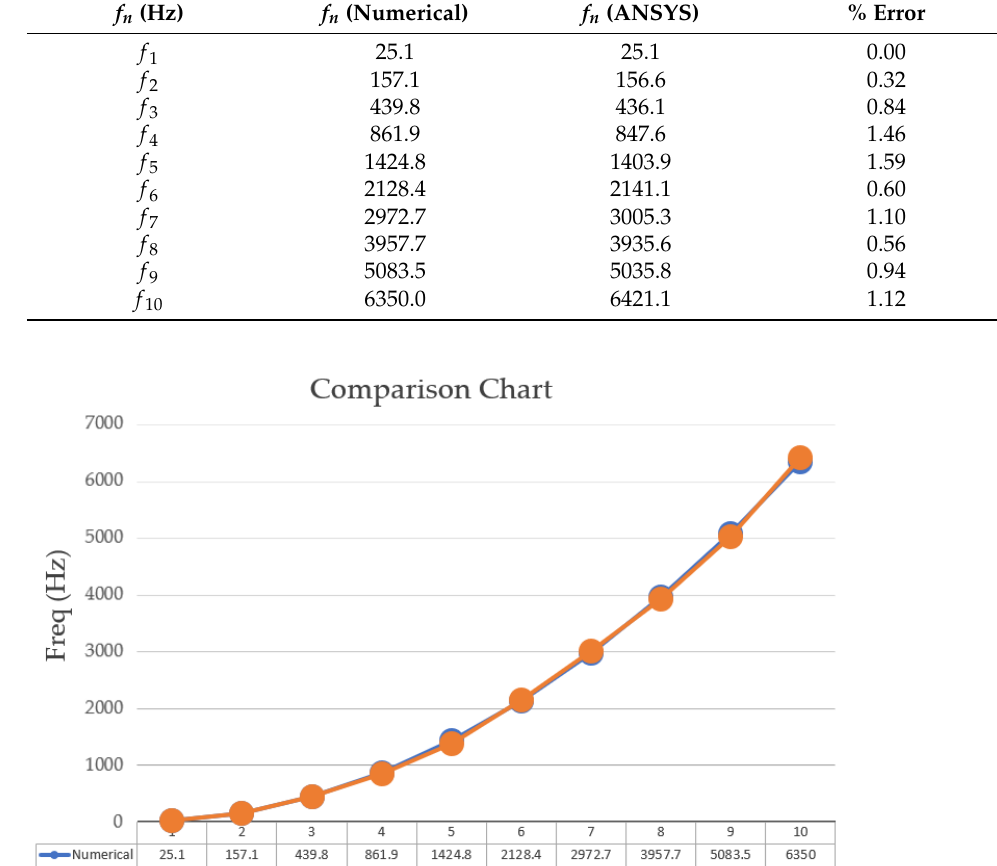
Table 4. Comparison of MATLAB (numerical) and ANSYS results.